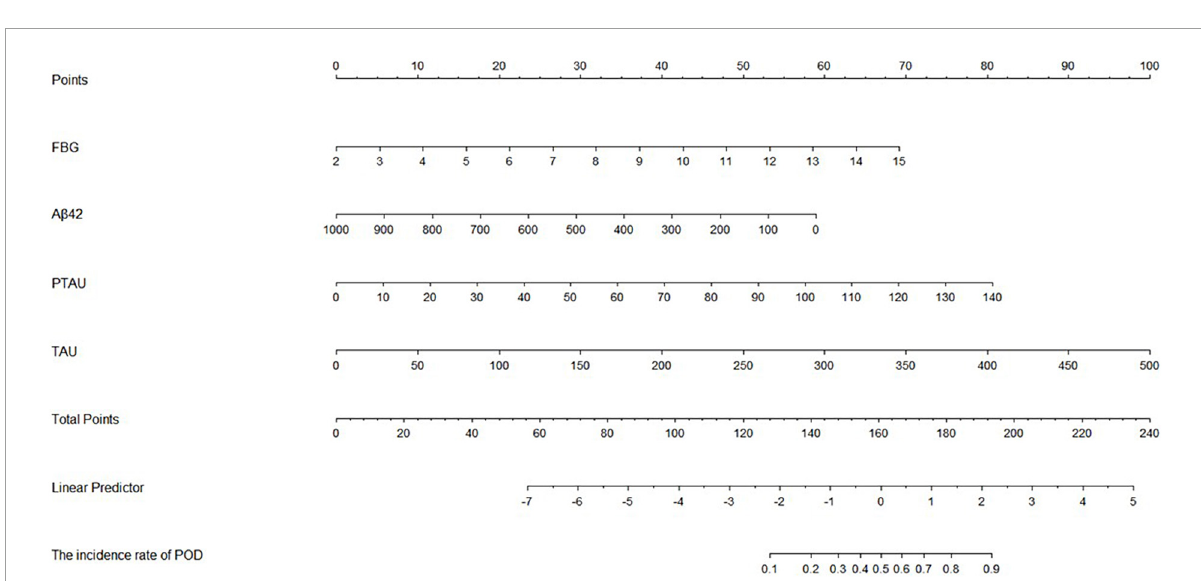
FIGURE7 Visualization for predictive factors. Nomogram showing the predictive ability of FBG and the CSF biomarkers. AUC, area under the curve; FBG, fasting blood glucose; A β 42, β -amyloid42; T-tau, total tau; P-tau, phosphorylated tau.